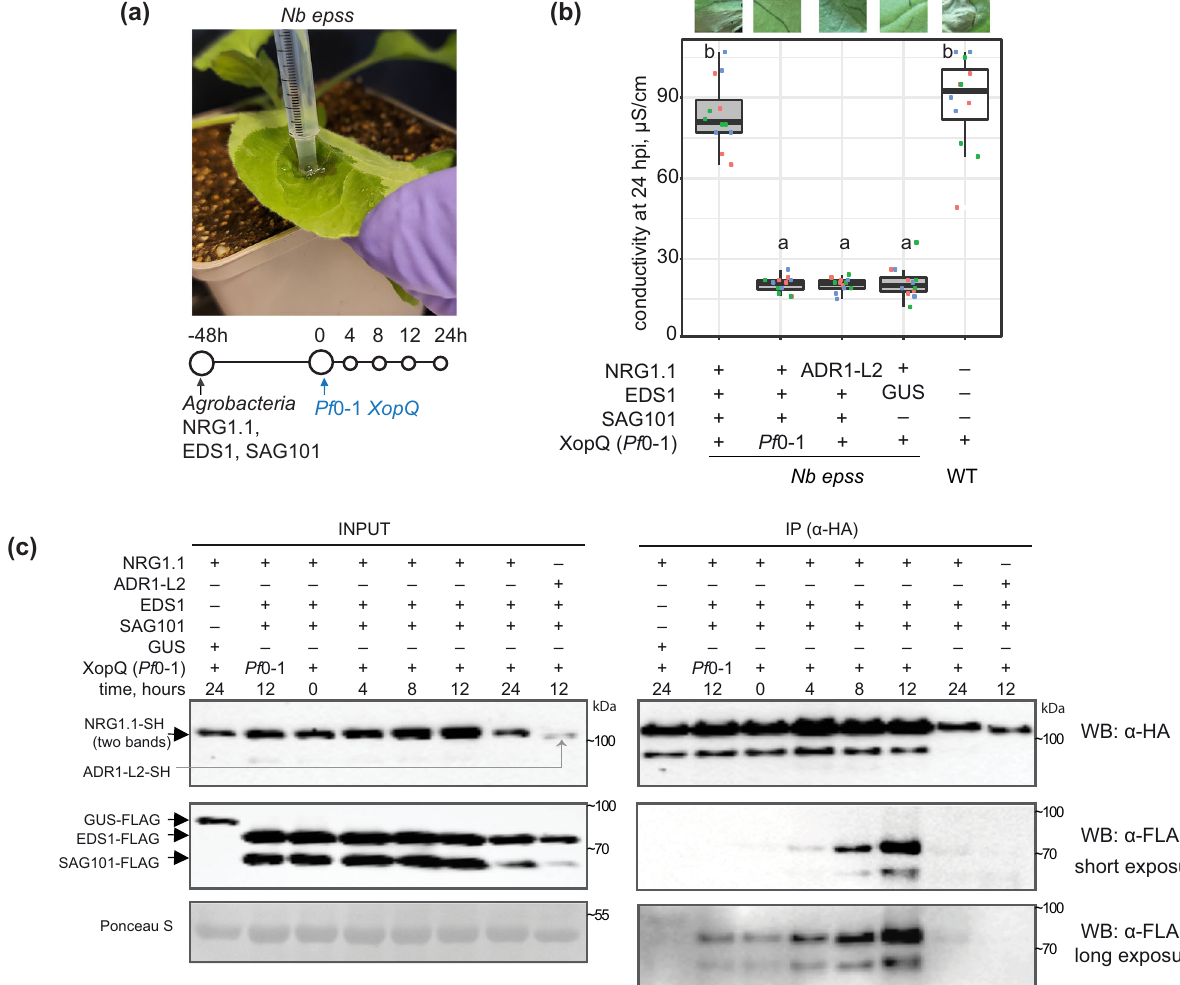
Fig. 4 XopQ/Roq1-dependent Arabidopsis NRG1.1 association with EDS1 and SAG101 in Nicotiana benthamiana . a Sample collection scheme for experiments in ( b ) and ( c ). Roq1-dependent cell death is restored in Nicotiana benthamiana ( Nb ) eds1 pad4 sag101a sag101b ( Nb epss ) signalling de fi cient mutant by expressing Arabidopsis EDS1, SAG101 and NRG1.1 via Agrobacteria in fi ltration 48 h before XopQ effector delivery. Pf 0-1 XopQ is syringe-in fi ltrated (OD 600 = 0.3) to deliver the effector and to study TNL signalling events in a time-resolved manner up to 24 hpi. b Macroscopic symptoms and quanti fi cation of XopQ-triggered cell death at 24 hpi after in fi ltrating Pf 0-1 XopQ in leaves of Nb epss expressing Arabidopsis EDS1-FLAG, SAG101-FLAG, NRG1.1-3xHA-StrepII (NRG1.1-SH) or ADR1-L2-3xHA-StrepII (ADR1-L2-SH). Pf 0-1 with empty vector ( Pf 0-1) served as a “ no-ETI ” control. Cell death was quanti fi ed in electrolyte leakage assays 6 h after harvesting leaf discs (24 hpi with Pf 0-1 XopQ ). The experiment was performed three times independently, each with four replicates (leaf discs) (Tukey ’ s HSD, α = 0.001, n = 12). Transiently expressed Arabidopsis EDS1, SAG101 and NRG1.1 proteins are functional in Pf 0-1 XopQ triggered (Roq1) cell death. Description of boxplots: minima — fi rst quartile, maxima — third quartile, centre — median, whiskers extend to the minimum and maximum values but not further than 1.5 interquartile range from the respective minima or maxima of the boxplot. Datapoints with the same colour come from one independent experiment. c Coimmunoprecipitation assay followed by Western blotting to test for XopQ-triggered associations between Arabidopsis NRG1.1-SH and FLAG-tagged EDS1 or SAG101 in Nb epss according to the in fi ltration scheme in ( a ). NRG1.1-SH or ADR1-SH were enriched using α -HA agarose beads, and presence of FLAG-tagged EDS1, SAG101 or GUS was tested by probing blots with α -FLAG antibodies. IP assays were conducted three times independently with similar results. NRG1.1 association with EDS1 and SAG101 requires Roq1/XopQ ETI activation. Pf 0-1